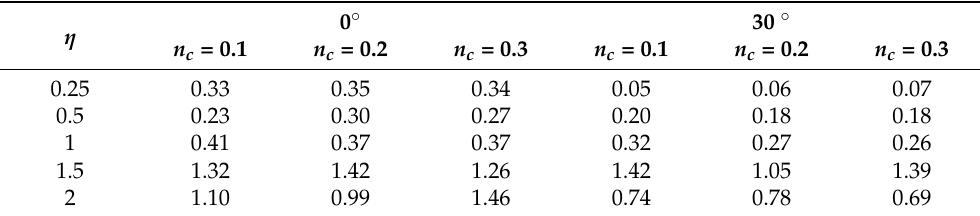
Table 5. Mean value of variation coefficient of vertical displacement amplitude (with sediment